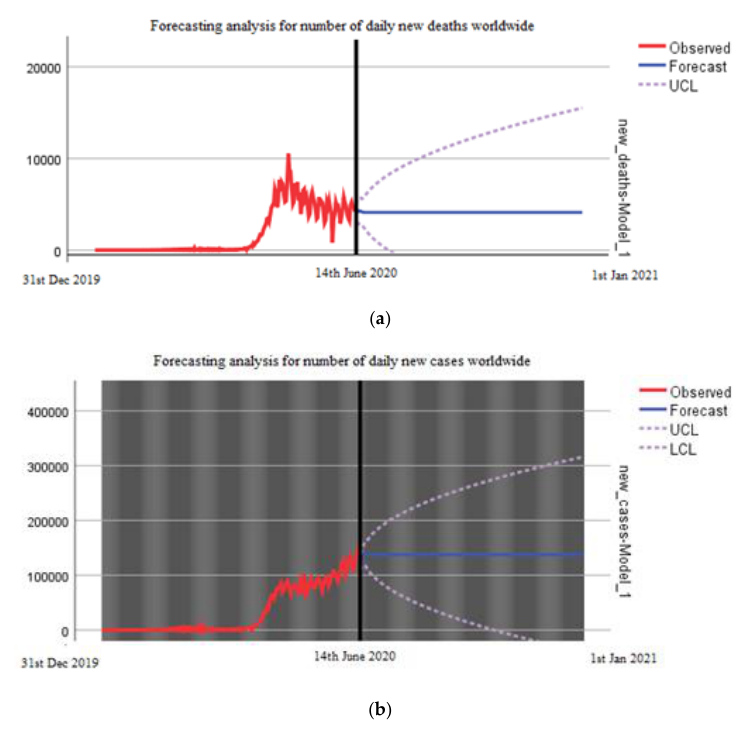
Figure 5. ( a ) Forecasting analysis for number of new daily deaths worldwide until 1st January 2021. ( b ) Forecasting analysis for number of new daily cases worldwide until 1st January 2021.